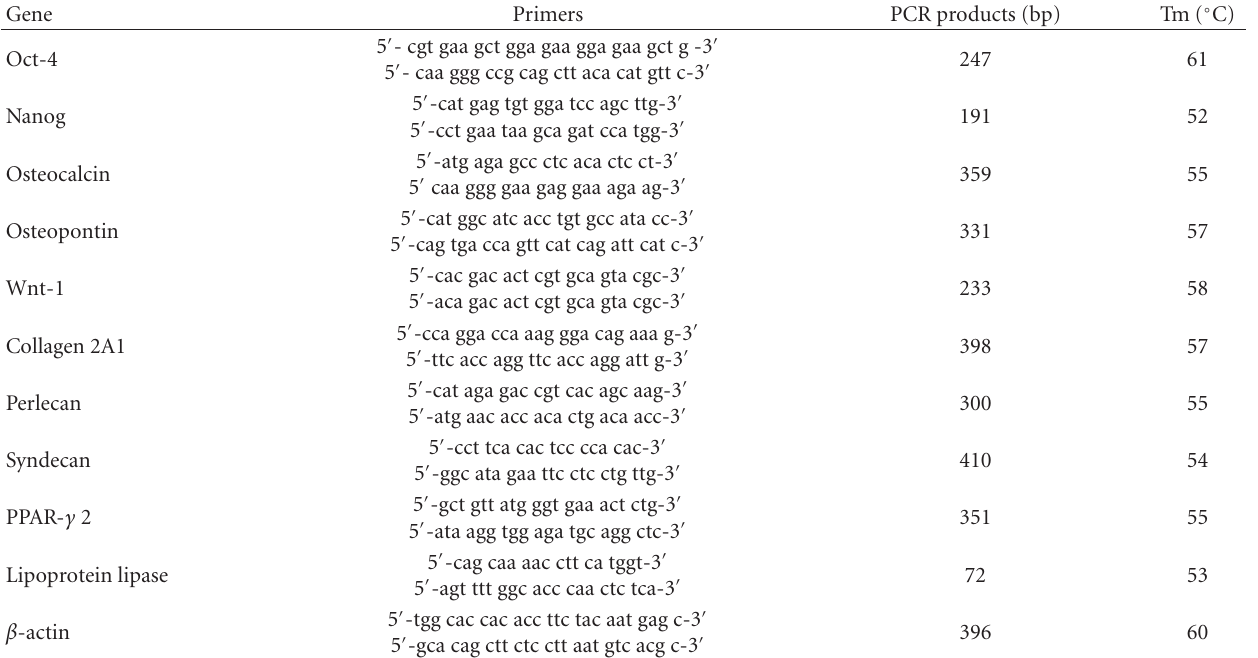
Table 1: RT-PCR primer